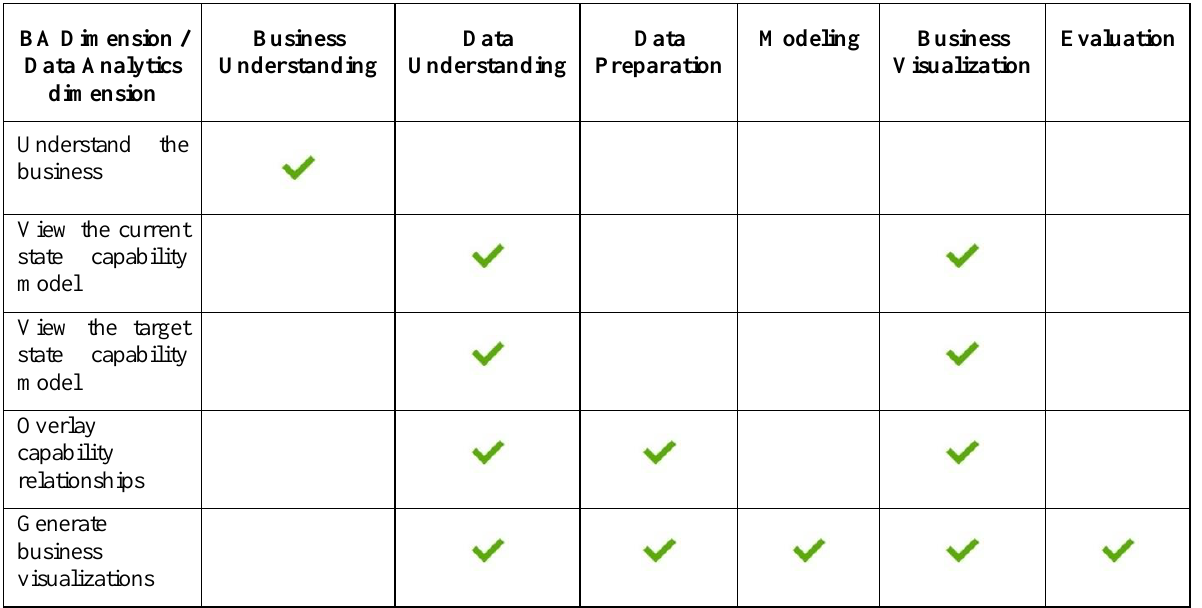
Table 3. Analytics-enabled Adaptive BA modeling